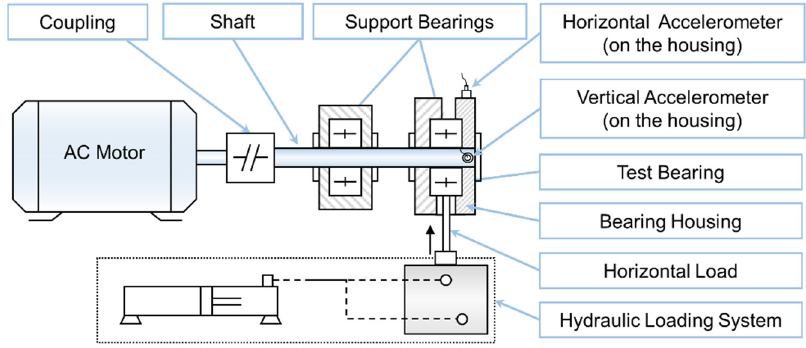
Figure 1. Schematic of the experimental rig with accelerometers